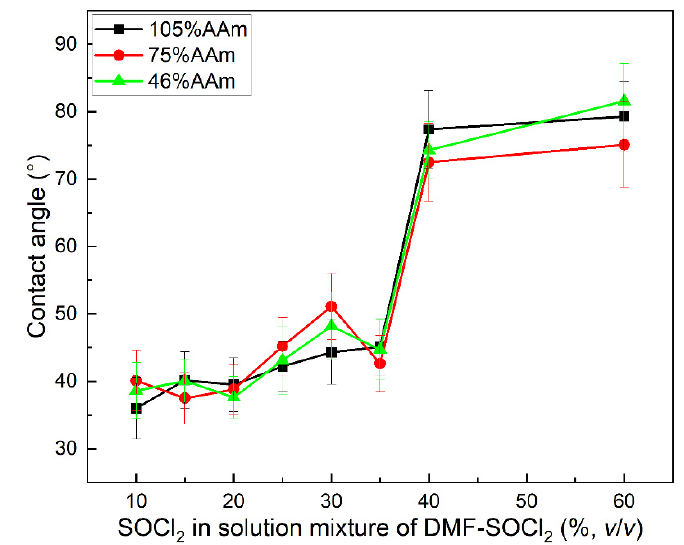
Figure 8. The effect of the SOCl 2 concentration on the sample’s contact angle.